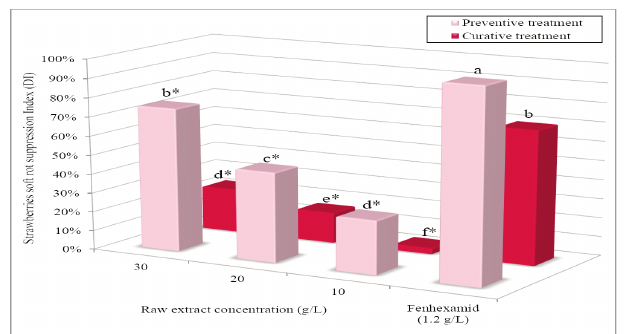
Fig. 3 - Strawberries Rhizopus soft rot suppression index (DI%) after 4 days of incubation at 20±2°C and 96±2% RH in the dark following to preventive and curative applications of 10 g L -1 , 20 g L -1 and 30 g L -1 Laminaria digitata raw extract, with respect to trial treated with Fenhexamid. Values ranging from 0% (no suppression) to 100% (total suppression) are the pooled mean of six replicates per treatment, each one carried out with thirty strawberries with two wounds per fruit. DI% values were analysed by two-way ANOVA. Asterisk indicates P-value ≤0.05 accor- ding to table 1. Histograms with different letters are significantly different according to DMRT (P≤0.05).